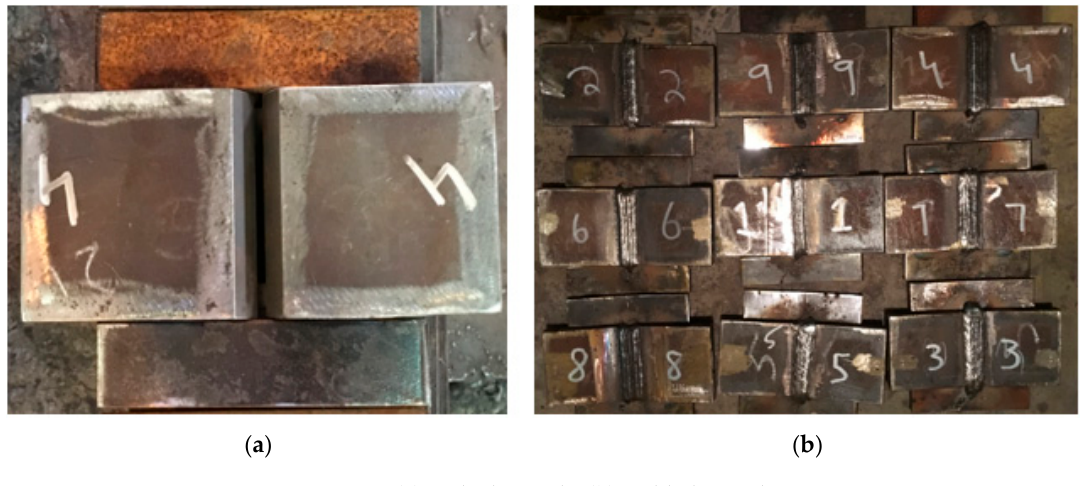
Figure 4. ( a ) Tacked Sample; ( b ) Welded Samples.